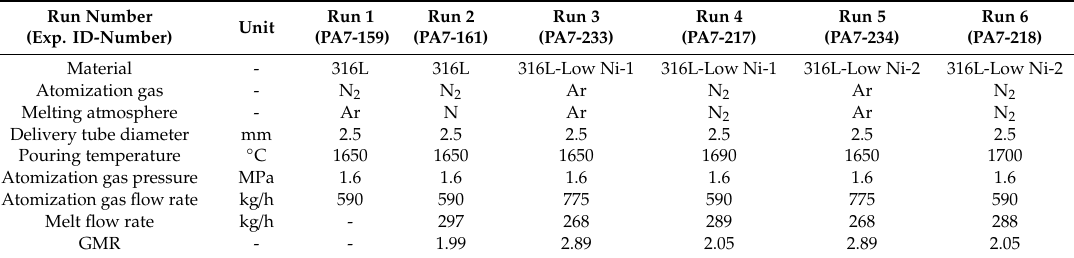
Table 2. Gas atomization parameters of 316L and modified 316L steel powder.